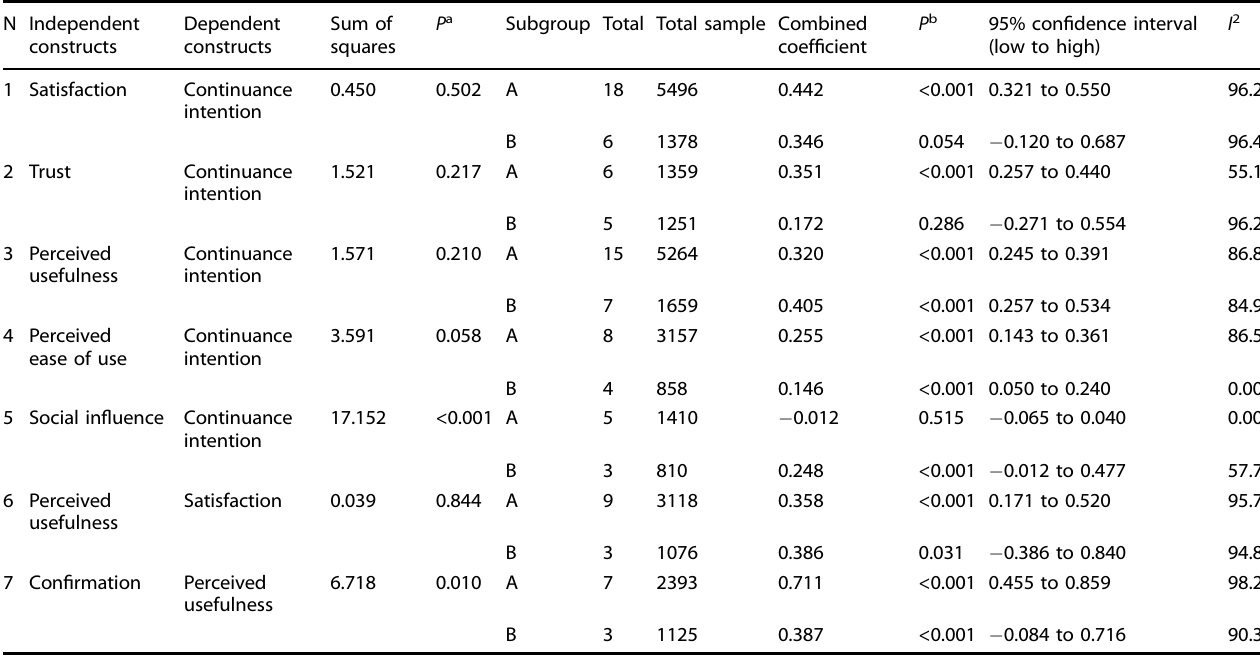
Table 3. Subgroup analysis by user